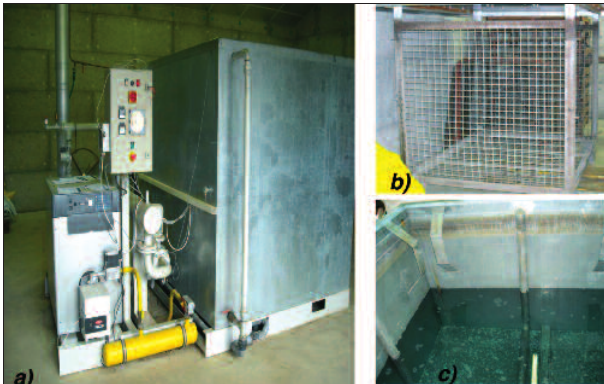
Fig 2: Patented device for hot water treatment of high number of grapevine propagating material in France : a) container part from outside (on the right ) and the controller part ( on the left ) of the device; b) basket for the propagating material to be dipped into the hot water of the container ; c) inside part of the container, where the propagating material will be soaked with agitation at 50 °C for 45